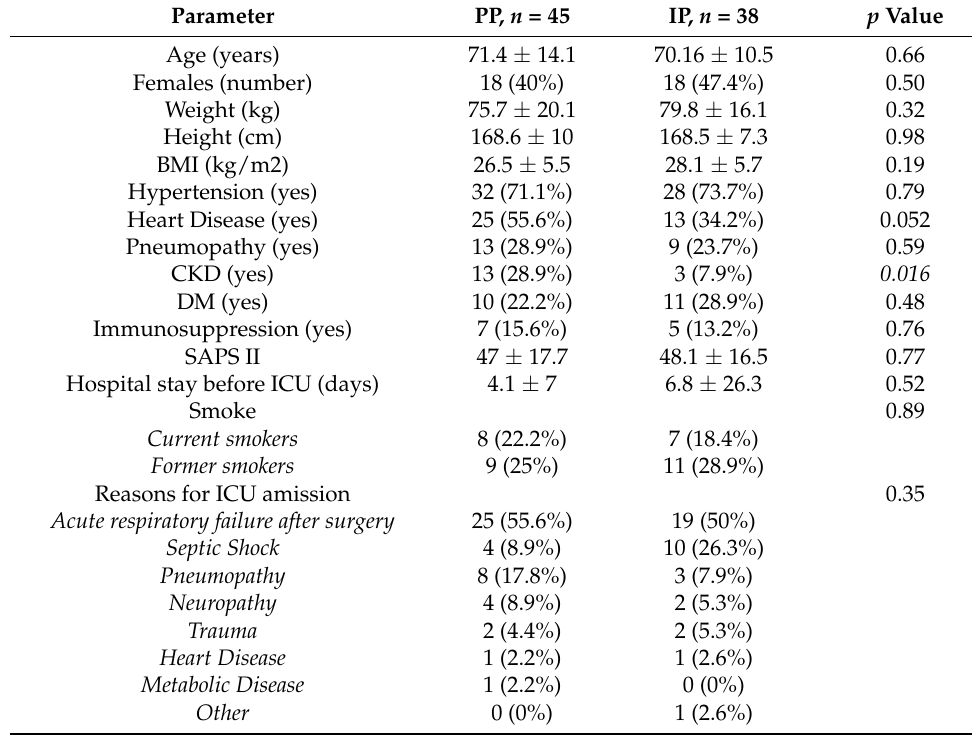
Table 1. Baseline characteristics at ICU admission, comorbidities, and entrance